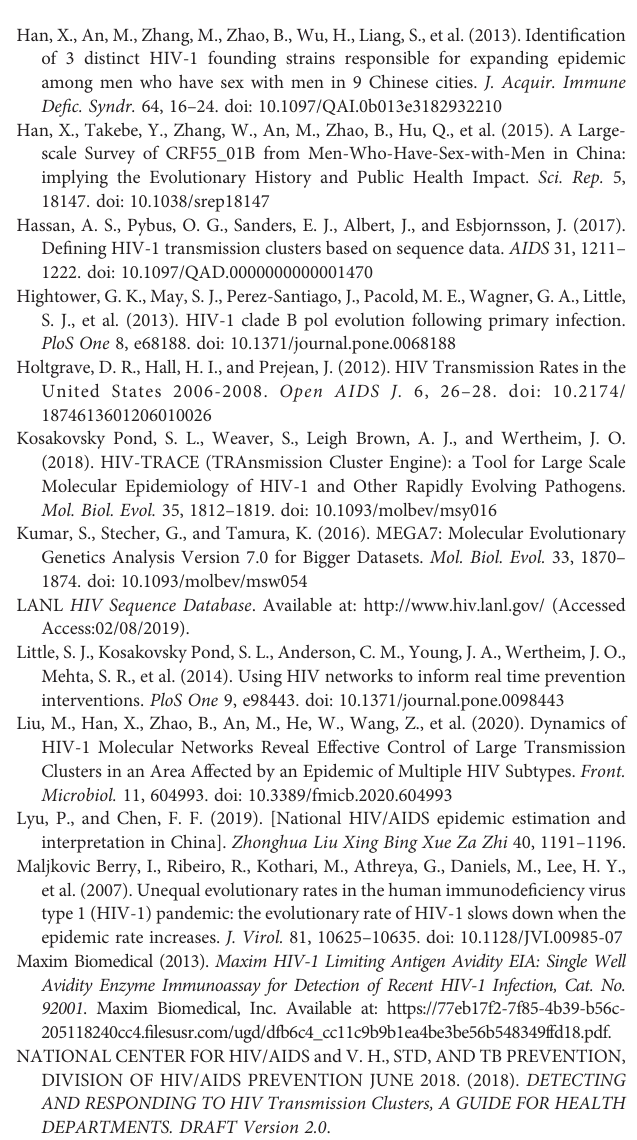
Supplementary Figure 1 | The molecular network of three main subtypes. a. the molecular network of CRF01_AE. b. the molecular network of CRF07_BC. c. the molecular network of B subtype. Red dots denote the individuals in priority clusters, blue dots denote the individuals in non-priority clusters, the triangle denote injection drug users, and the square denote the individuals with transmitted drug